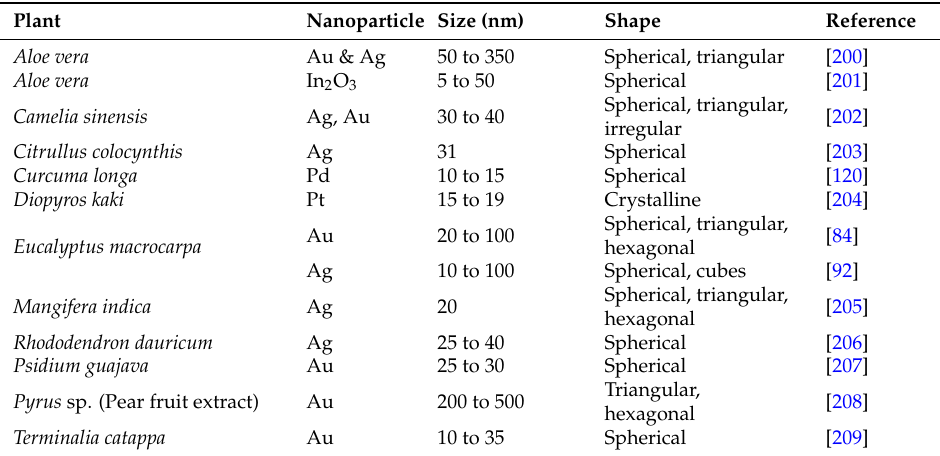
Table 2. A selection of nanoparticles synthesized by various